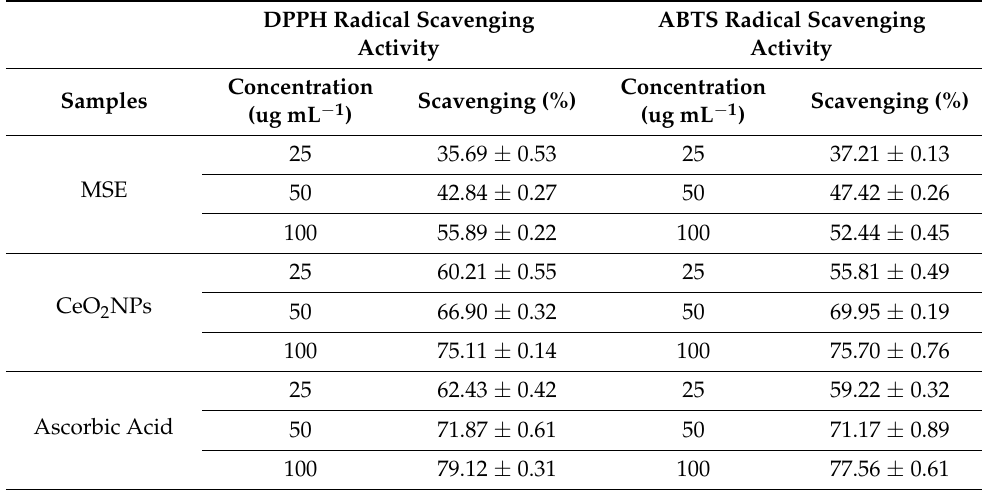
Table 3. DPPH • and ABTS scavenging activities for different concentrations of MSE and biogenic CeO 2 NPs, and ascorbic acid as the